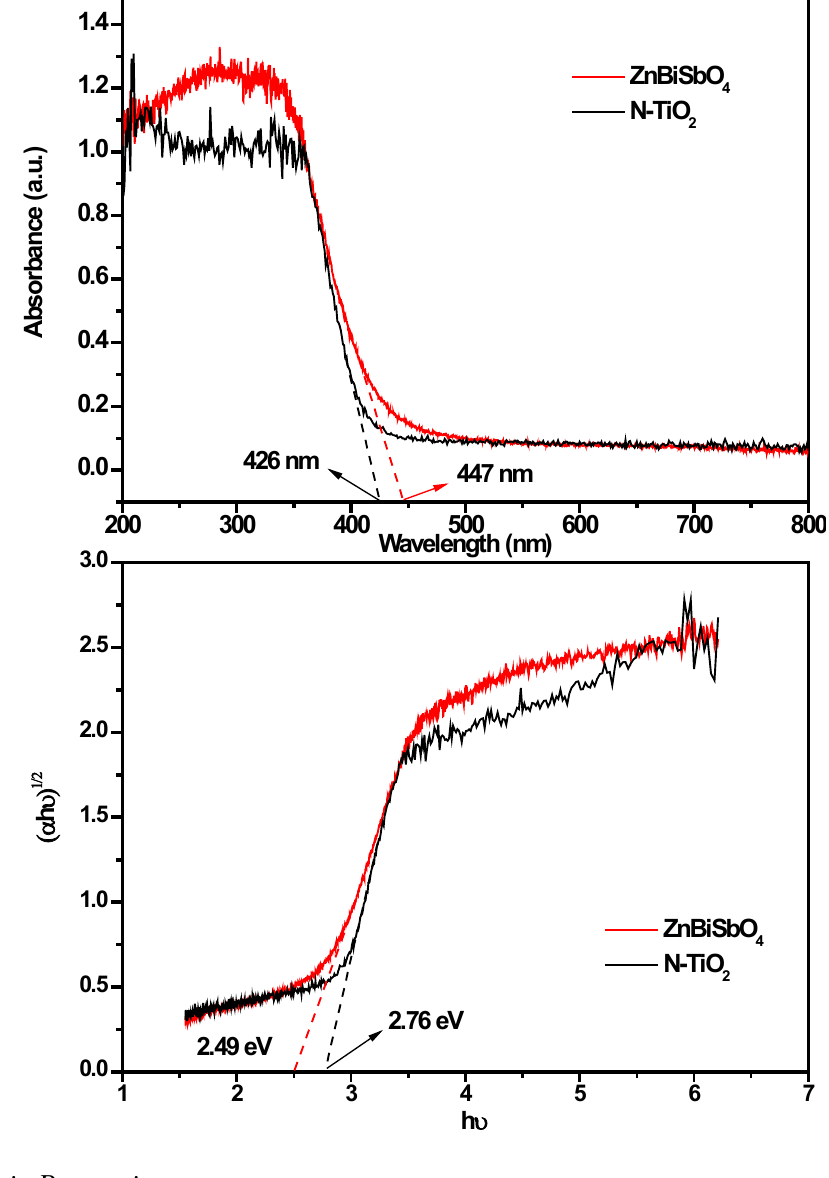
Figure 8. The absorption spectrum, plot of (α h ν) 1/2 vs. h ν for ZnBiSbO 800 °C for 35 h and N-TiO